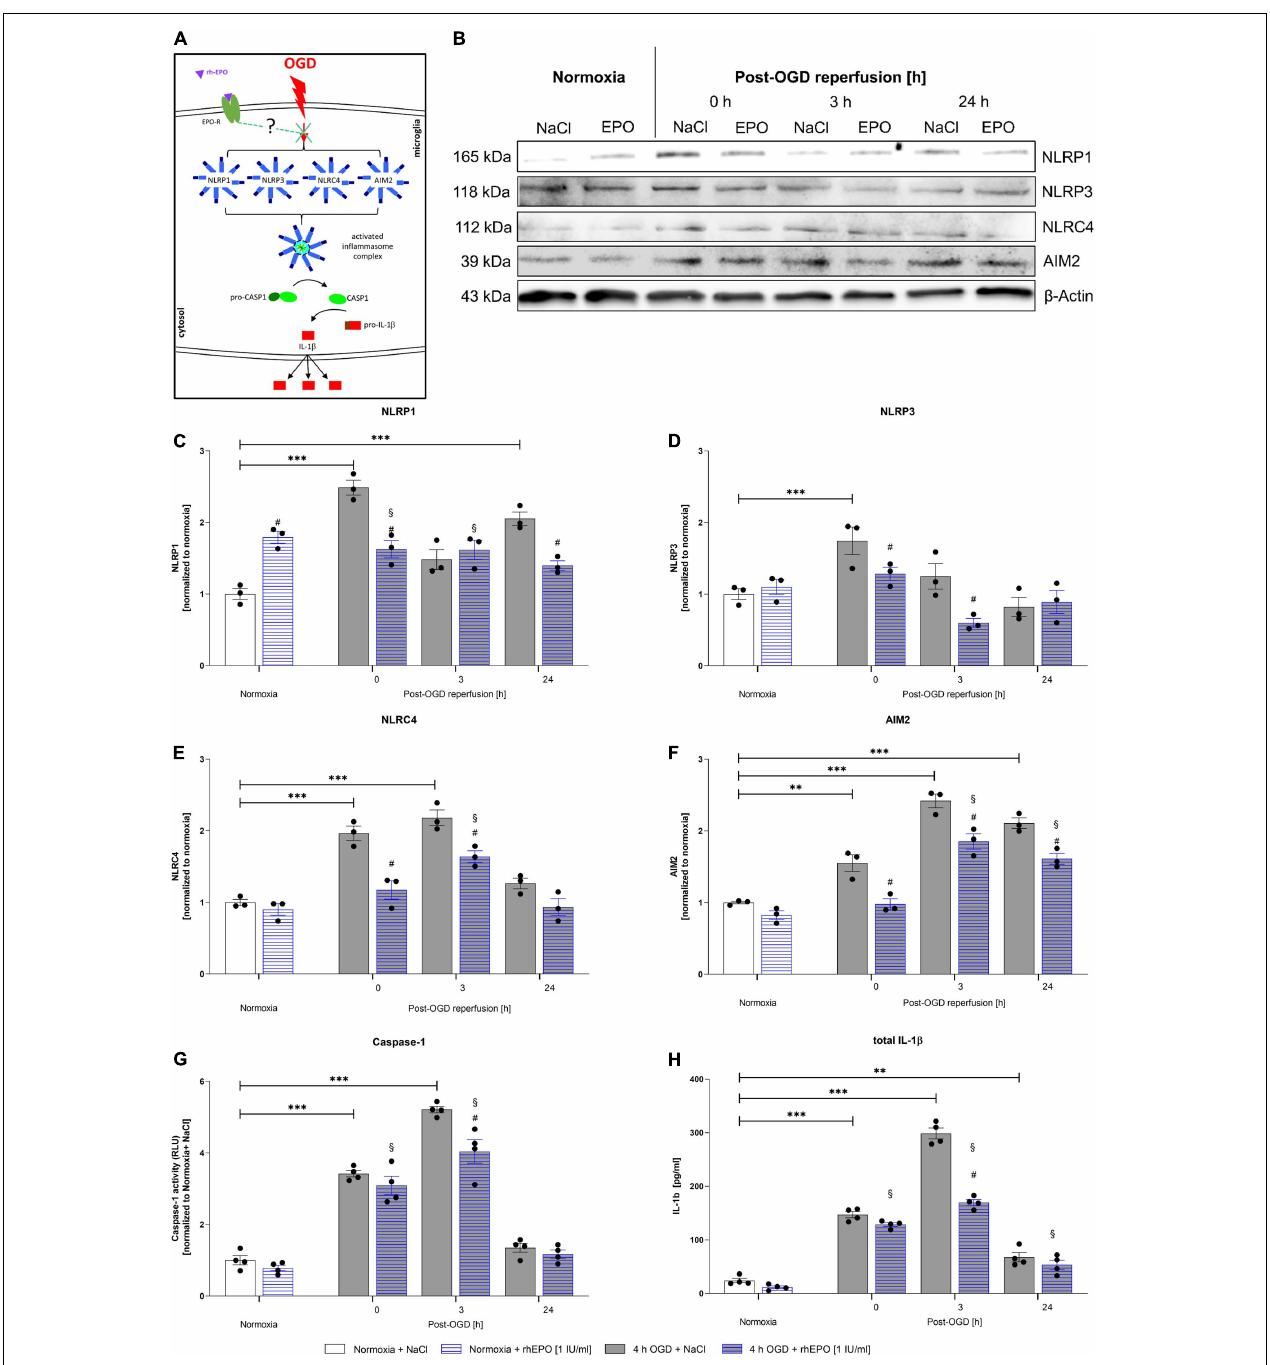
FIGURE 6 | Recombinant human erythropoietin abrogates an upregulation of the NLRP1, NLRP3, NLRC4, and AIM2 inflammasomes and of CASPASE1 and IL-1 β protein levels after 4 h of OGD followed by a reperfusion period of 24 h. HMC-3 cells were treated with a single-dose of rhEPO [1 IU/ml] prior to 4 h of OGD followed by a reperfusion period of (up to) 24 h. Saline served as vehicle control (0.9% NaCl). (A) Schematic illustration addressing the potential impact of rhEPO and OGD on the activation of inflammasomes. (B) Representative Western blot images of NLRP1, NLRP3, NLRC4, AIM2, and β -Actin protein levels. (C–F) Densitometric quantification of protein levels normalized to saline normoxia control. β -Actin served as loading control. Intergroup differences were tested by ANOVA two-way followed by Tukey post hoc test (multiple comparison). Bars represent means ± SD of 3 individual experiments, individual data points are shown. ∗ p < 0.05, ∗∗ p < 0.01, ∗∗∗ p < 0.001 between groups, § p < 0.05 compared to normoxia + NaCl. # p < 0.05 compared to vehicle group. (G) CASPASE1 activity was assessed by CASPASE1-Glo R (cid:13) assay and normalized to normoxia saline control. (H) IL-1 β concentrations [pg/ml] in the supernatant of HMC-3 cells were determined by ELISA. Bars represent means ± SD of 4 individual experiments with 3 technical replicates in each experiment, individual data points are shown. ∗ p < 0.05, ∗∗ p < 0.01, ∗∗∗ p < 0.001 between groups, § p < 0.05 compared to normoxia + NaCl. # p < 0.05 compared to vehicle group.